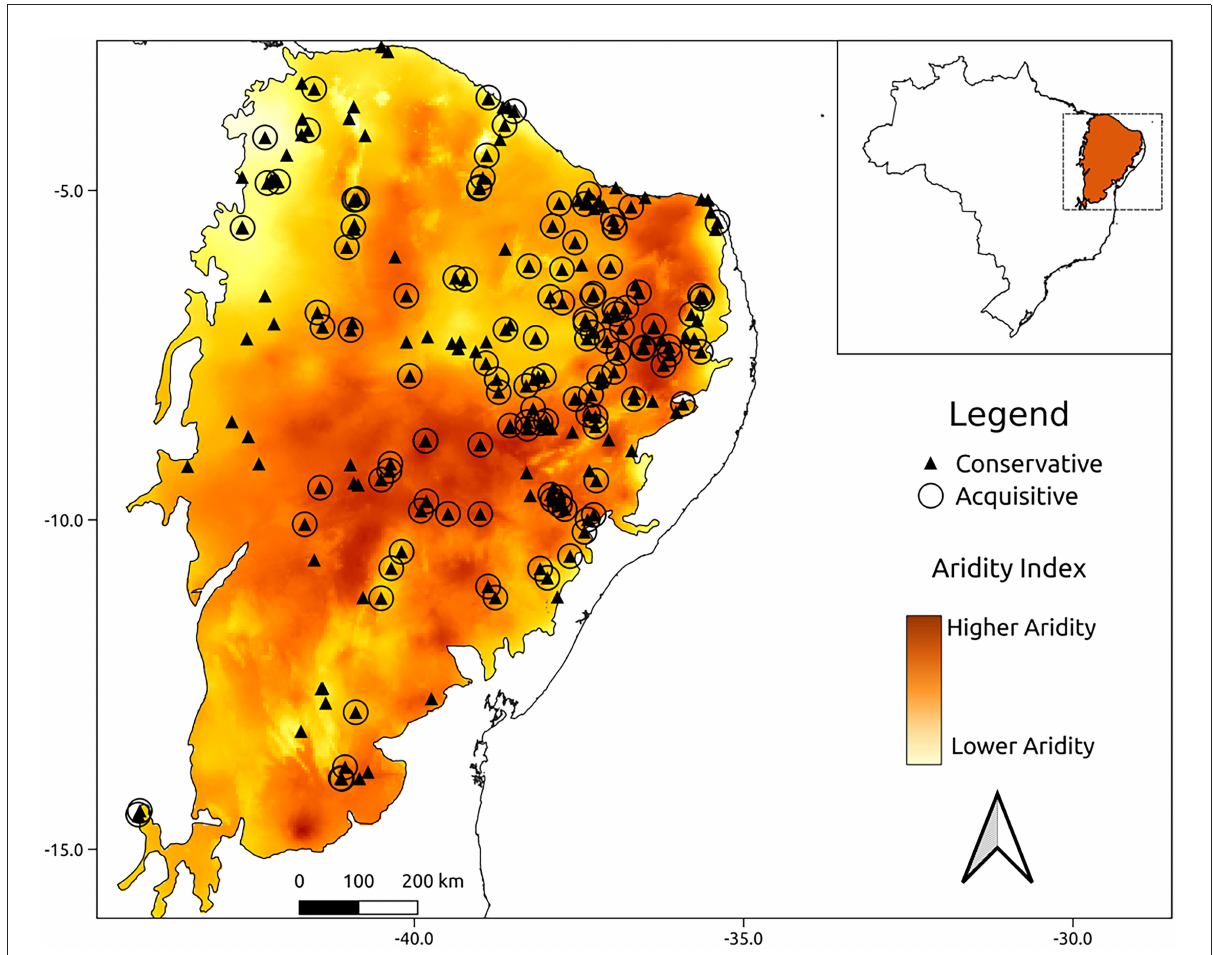
FIGURE3 Spatial distribution of functional groups along the Caatinga biome. The acquisitive functional group is represented by O and the conservative functional group is represented by N . The colors indicate the aridity index calculated for 30 years, from 1970 to 2000, the dark colors indicate greater aridity areas and the light colors represent lower aridity